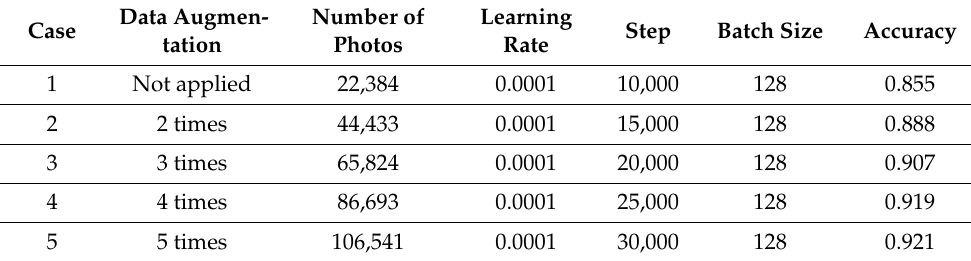
Table 3. Comparison of classification accuracy by case with training data.